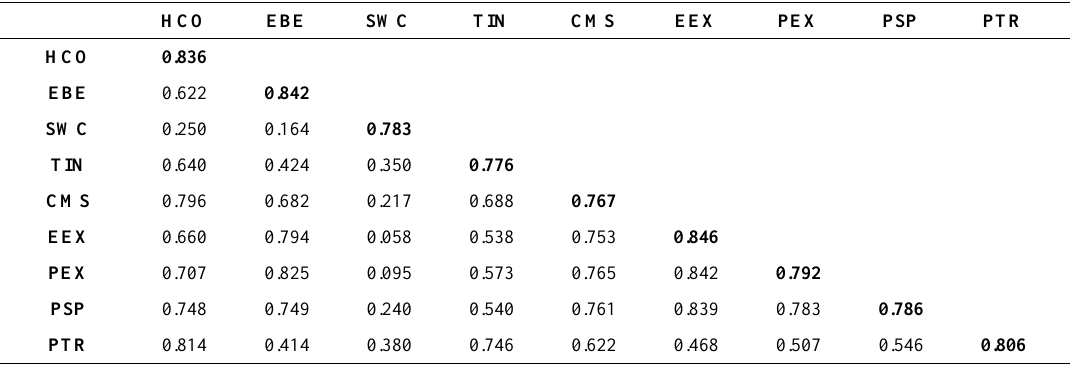
Table 3. Construct correlations and the square root of AVE